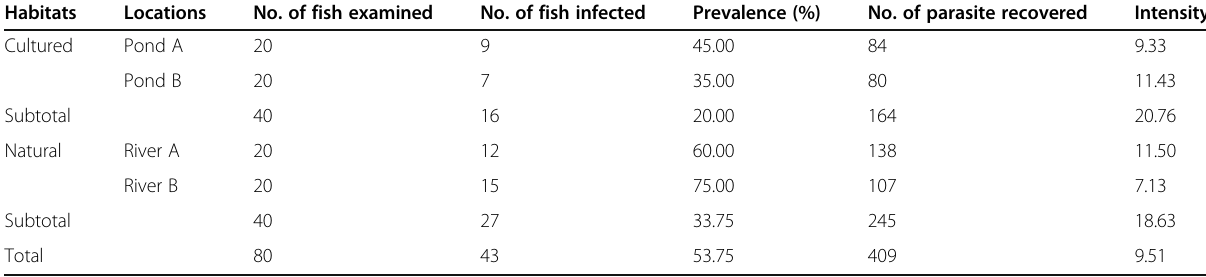
Table 1 Prevalence and intensity of parasites from the cultured and natural habitats